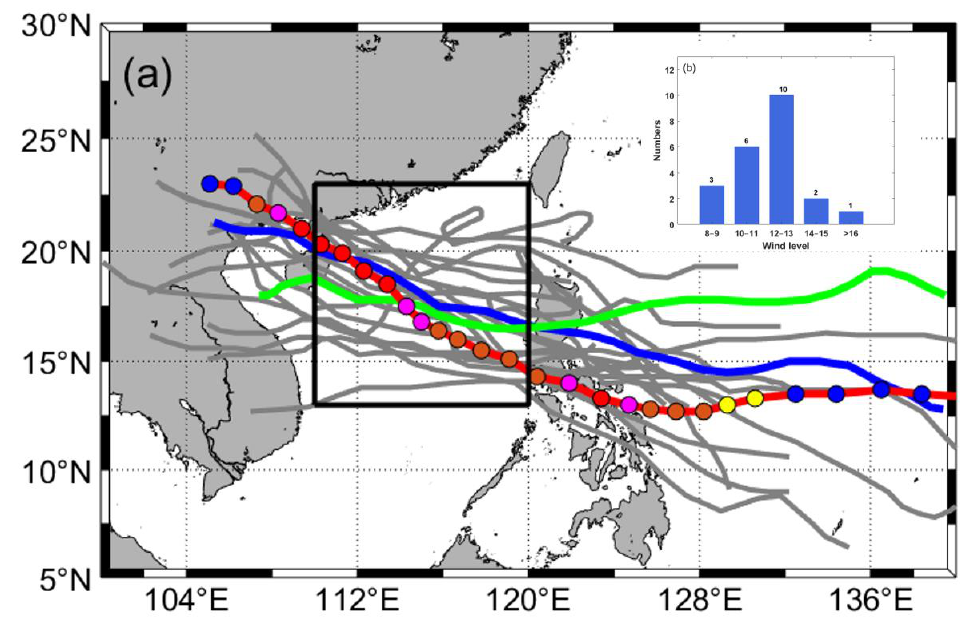
Figure 10. The track ( a ) of the typhoons passing through the study area of the South China Sea (110 ◦ E–120 ◦ E, 13 ◦ N–23 ◦ N) from 2008 to 2018 and the statistics of the maximum level when passing through the study area ( b ) (Blue line represents Nesat, green line Nalgae, and red line Rammasun). The discs represent the locations of the typhoons and the color of each disc represents the intensity of the typhoons, following the color categorization in Figure 2a.